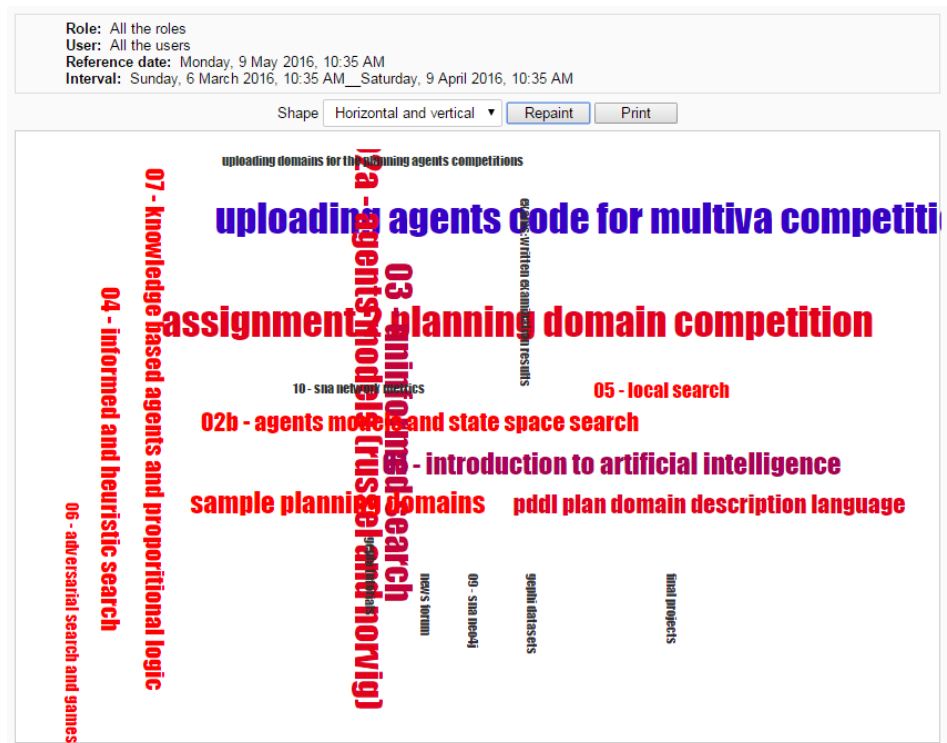
Figure 9. Tag cloud mode in Horizontal and Vertical